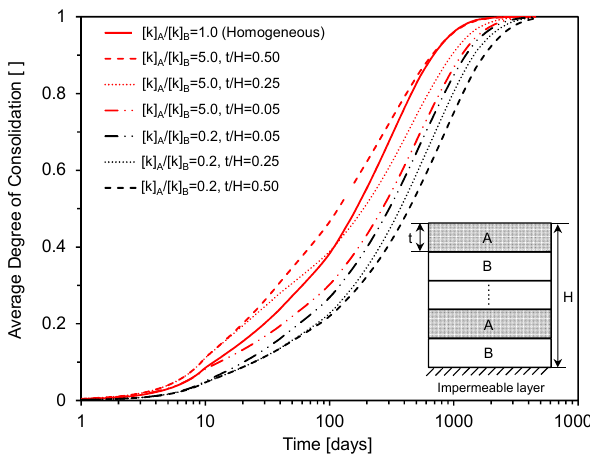
Figure 1. Effects of heterogeneity configurations on one-dimensional consolidation process of soils with binary layers. All the cases have the same arithmetic mean of consolidation coefficient.